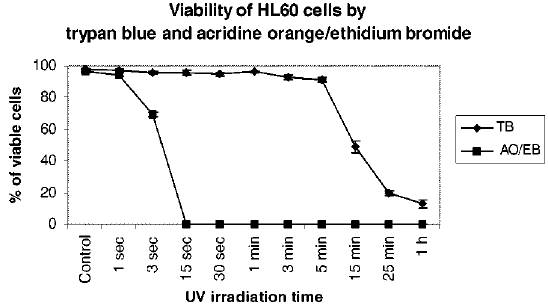
Fig. 2. Comparison of percentage of viable HL60 cells as measured by two different methods: trypan blue exclusion assay (— F —; TB) and AO/EB double staining (— 2 —; AO/EB). The results represent the mean of five independent experiments (cid:6) standard